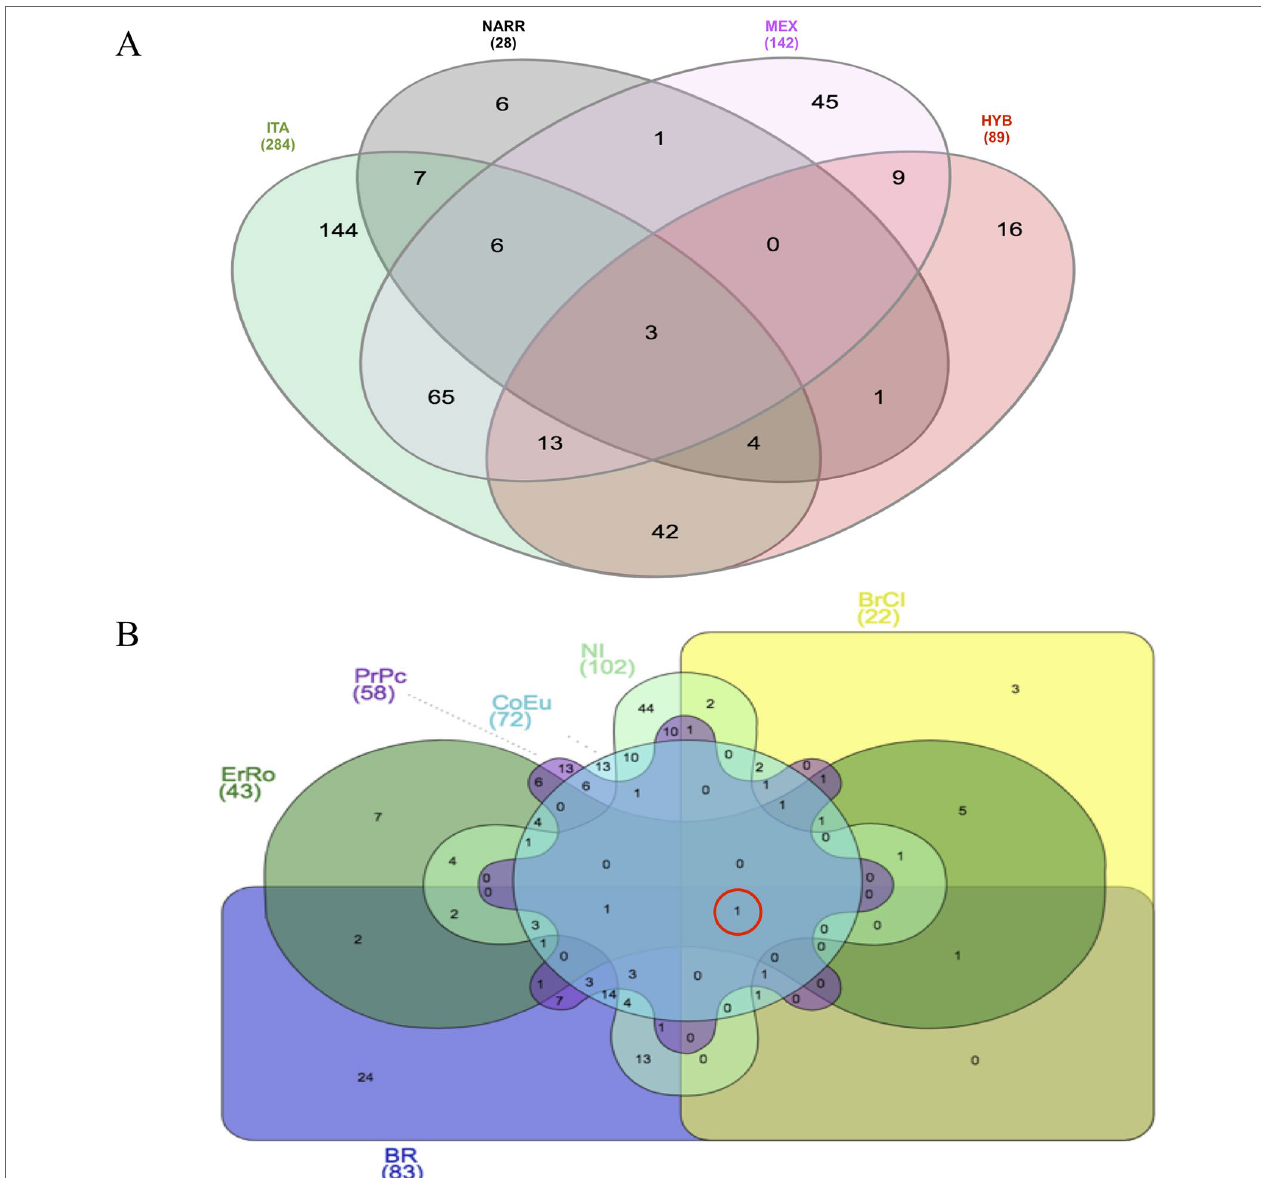
FIGURe 2 | Venn diagrams of CNVRs identified: (A) in turkeys grouped according to ITA-breeds; NARR; MEX and HYB; (B) in the six Italian turkey breeds.